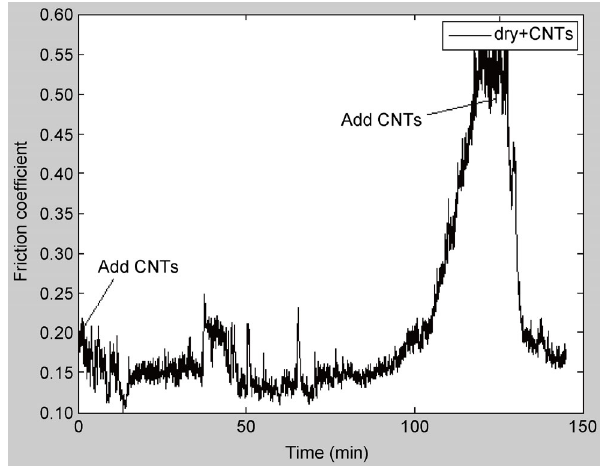
Fig. 4 Friction coefficient with CNTs in a long time.